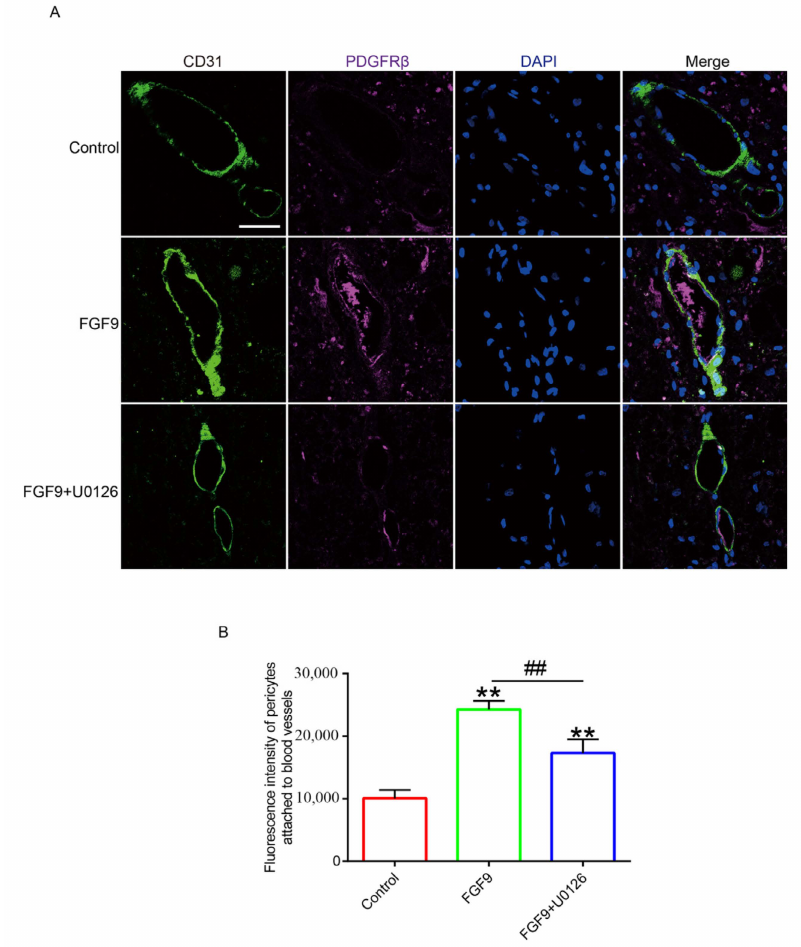
Figure 5. FGF9 improved vascular stability in random flaps. ( A ) Immunofluorescence staining of CD31 (green) and PDGFR β (purple) in each group. DAPI(blue) was used to label nuclei. Magnifica- tion = 80 × ; scale bar = 25 µ m. ( B ) CD31 and PDGFR β fluorescence intensity statistics. ** represents p < 0.01 versus the control group, and ## represents p < 0.01 comparing the FGF9 group with the FGF9+U0126 group, indicating statistical significance. Data are the mean values ± SD, n =